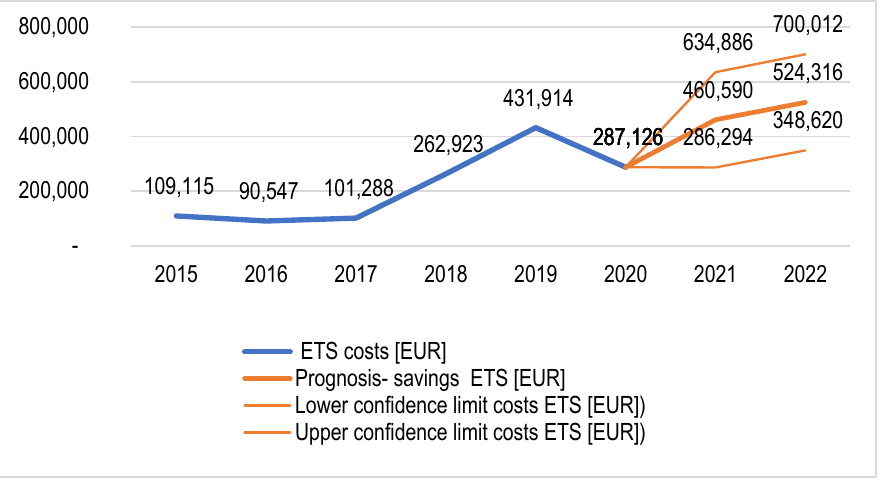
Figure 17. EU ETS savings (2015 – 2020) and forecast EU ETS savings. Source: developed by the authors.